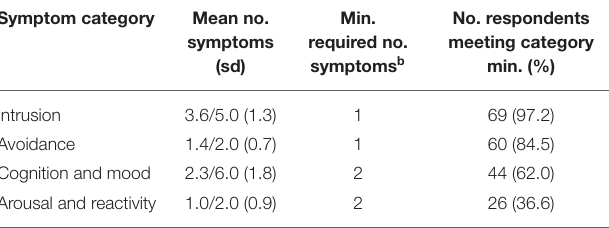
TABLE 7 | Self-reported posttraumatic stress symptoms among survey respondents ( n = 71) a . Symptom